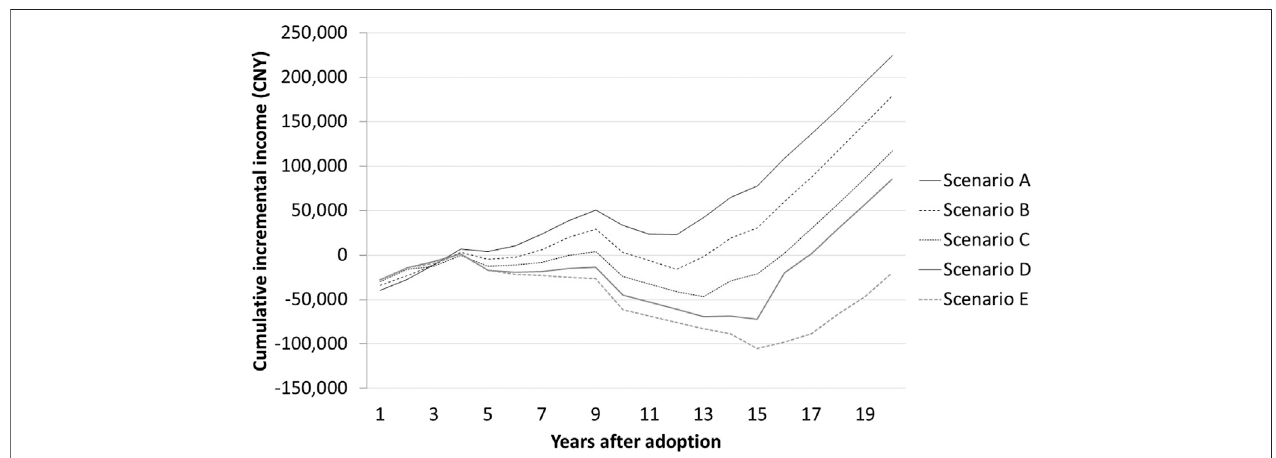
FIGURE 2 | Cumulative incremental net income of the household in the scenarios modeled (Chinese Yuan, CNY).